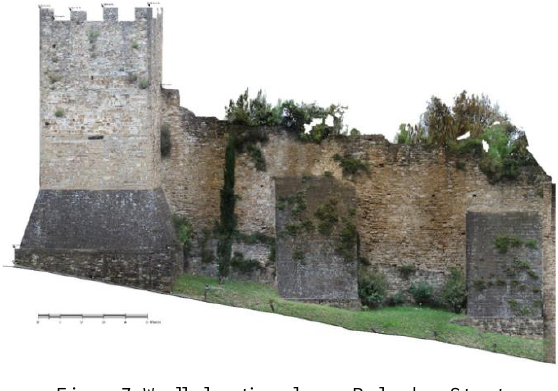
Figure 7. Wall elevation plan on Belvedere Street